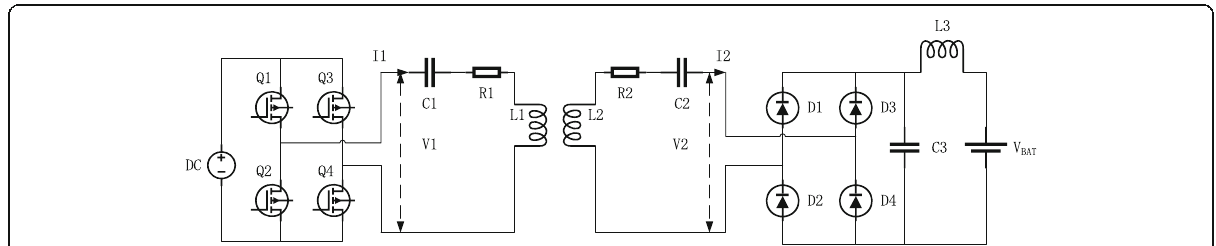
Fig. 3 Circuit of WPT charging system with series-series (S-S)